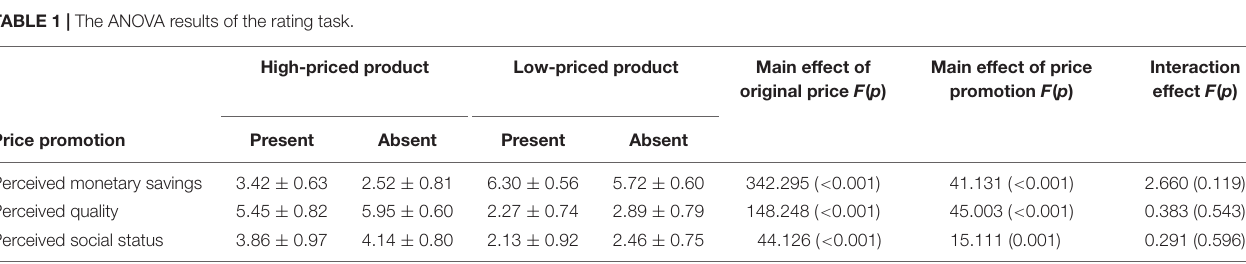
Main effect of price Interaction original price F ( p ) promotion F ( p ) effect F ( p